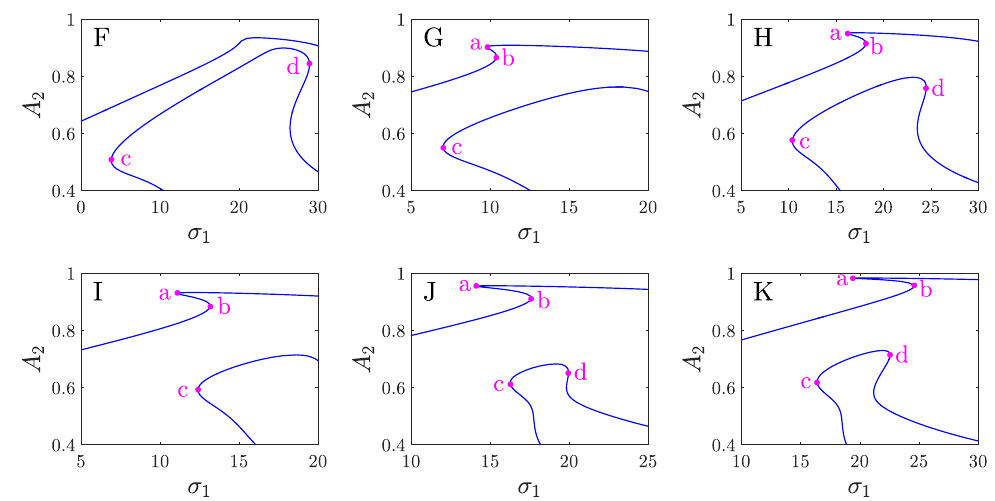
Figure 10. Local enlargements of subplots F through K of Figure